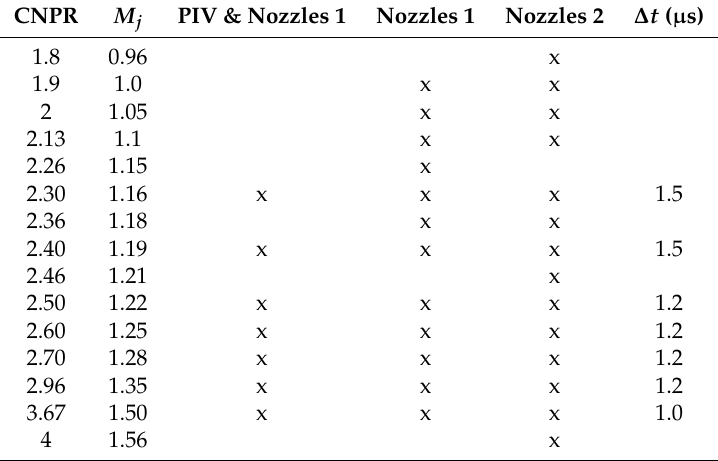
Table 4. Overview of the test conditions investigated during the three campaign carried out using PIV and microphones. Nozzle Set 1 has D 1 = 0.0240 m, while Nozzle Set 2 has D 1 = 0.0192